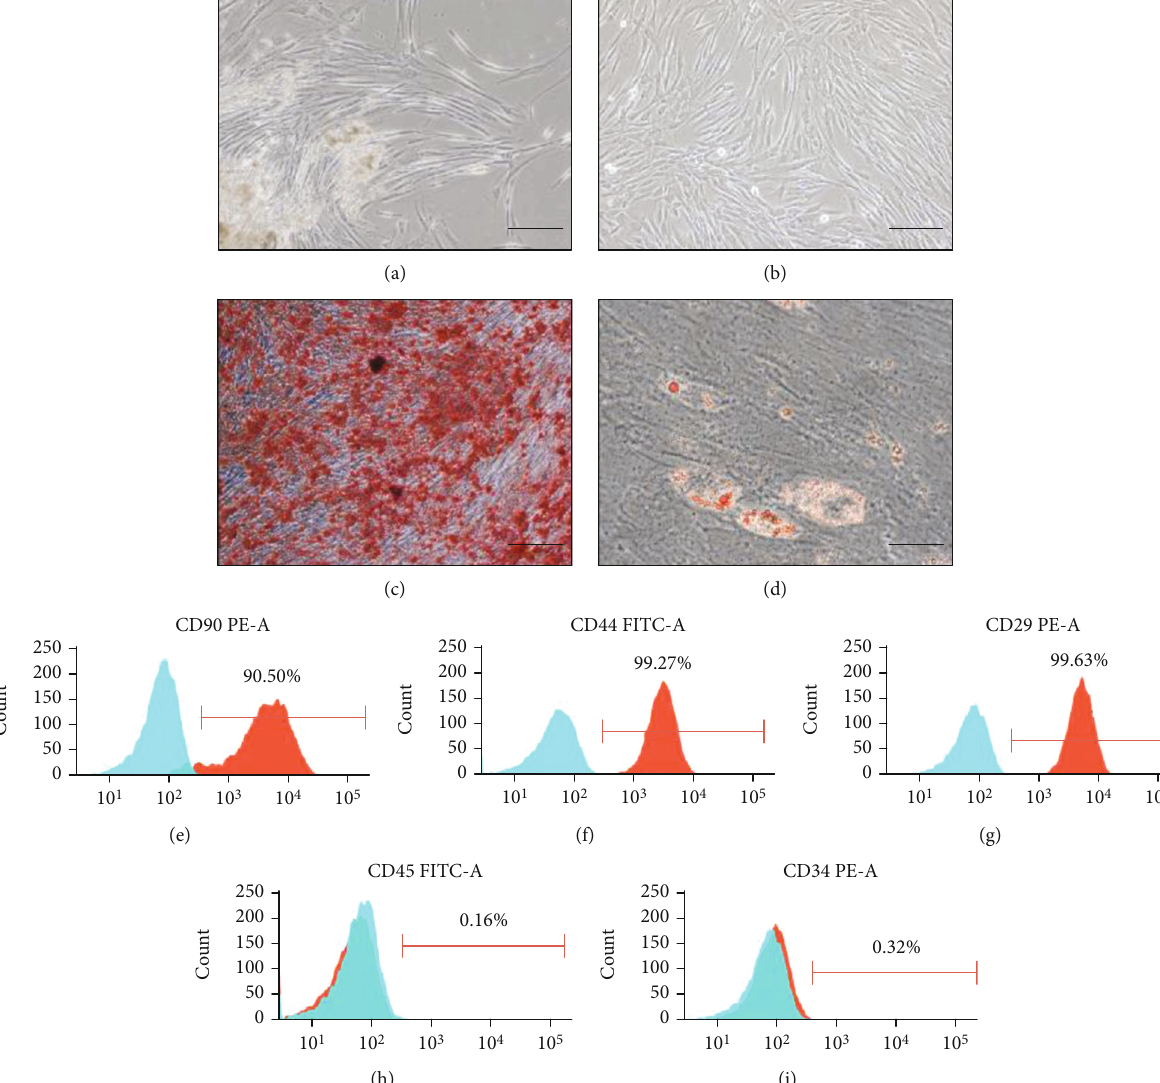
Figure 2: Isolation and identi fi cation of hDPSCs. (a) Primary cultured hDPSCs (scale bar, 200 μ m). (b) The cell morphology of hDPSCs was observed under an optical microscope (scale bar, 200 μ m). (c) Osteogenic di ff erentiation assay of hDPSCs (scale bar, 200 μ m). (d) Adipogenic di ff erentiation assay of hDPSCs (scale bar, 50 μ m). ( e – i ) Flow cytometry assays showed high levels of the mesenchymal stem cell markers CD90 (90.50%), CD44 (99.27%), and CD29 (99.63%) and low levels of the hematopoietic cell markers CD45 (0.16%) and CD34 (0.32%) in